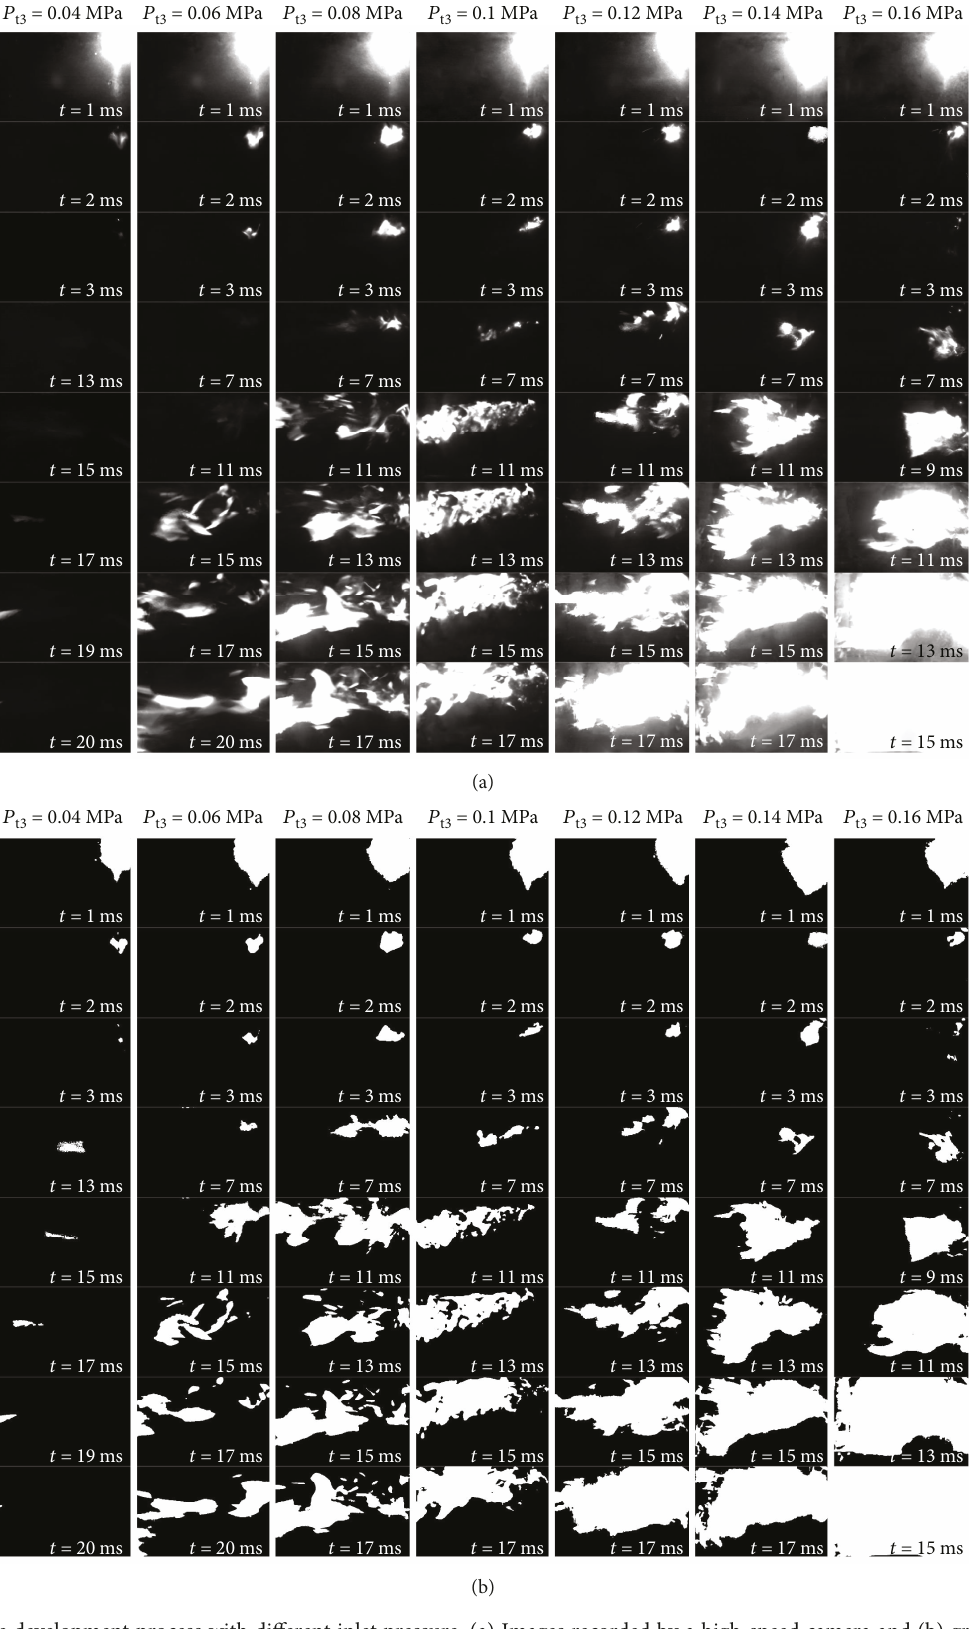
Figure 3: Flame development process with di ff erent inlet pressure. (a) Images recorded by a high-speed camera and (b) graphs done with threshold segmentation